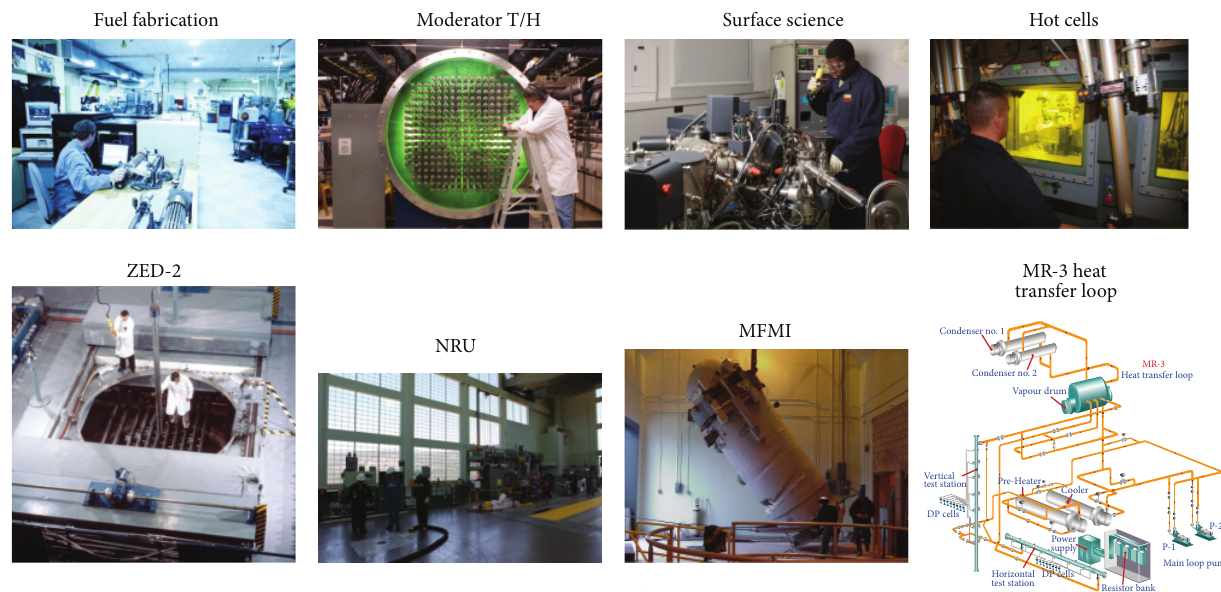
Figure 4: AECL nuclear safety R&D